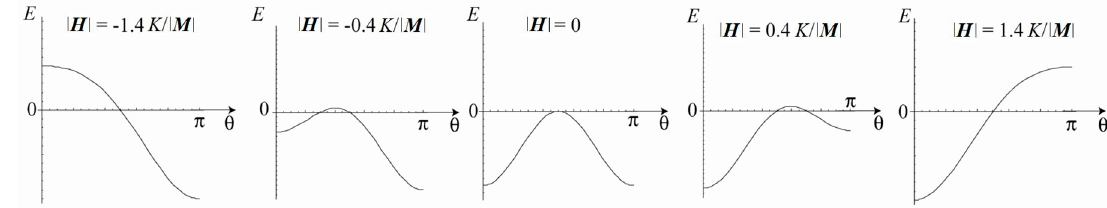
Figure 2. Calculated magnetic energy E as a function of angle θ with respect to the applied field H ( − 1.4 K /| M | ≤ | H | ≤ 1.4 K /| M |) confined along the z- axis. As shown in the fi gure above, for − K /| M | < | H | < K /| M |, there are two minima of energy in the